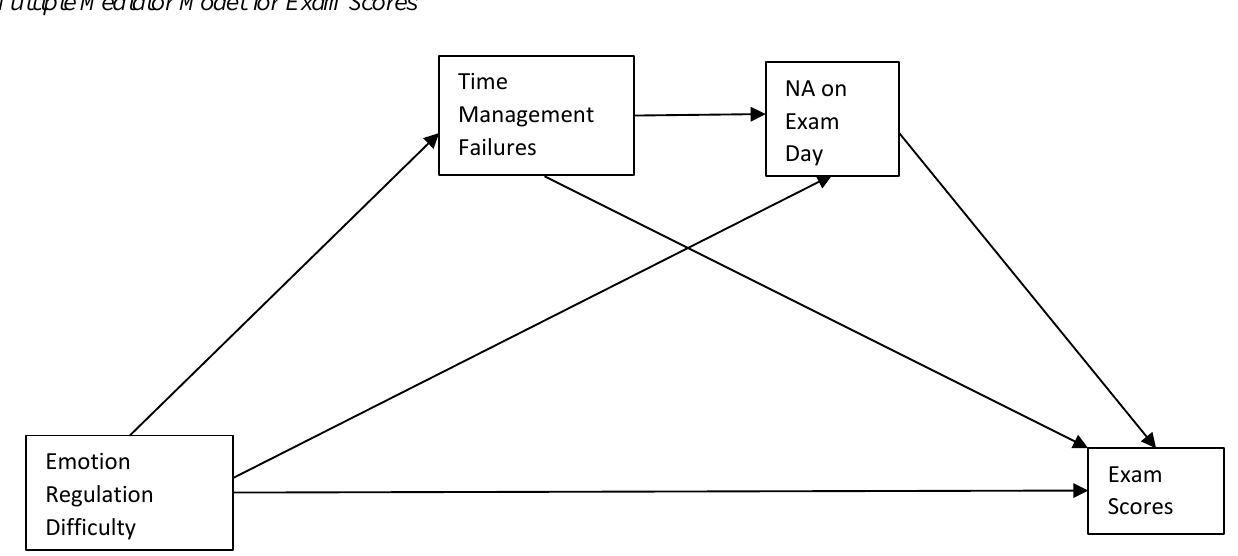
Multiple Mediator Model for Exam Scores